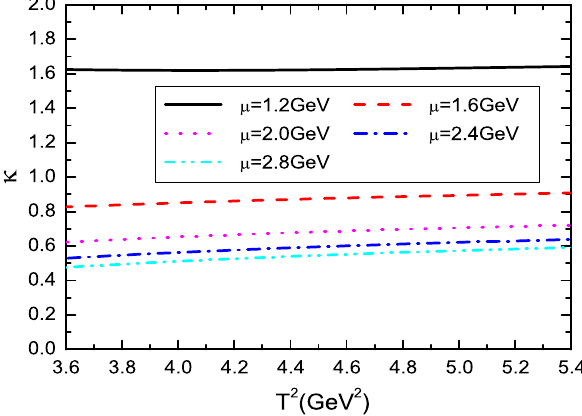
Fig. 5 The coefficient κ with variation of the Borel parameter T